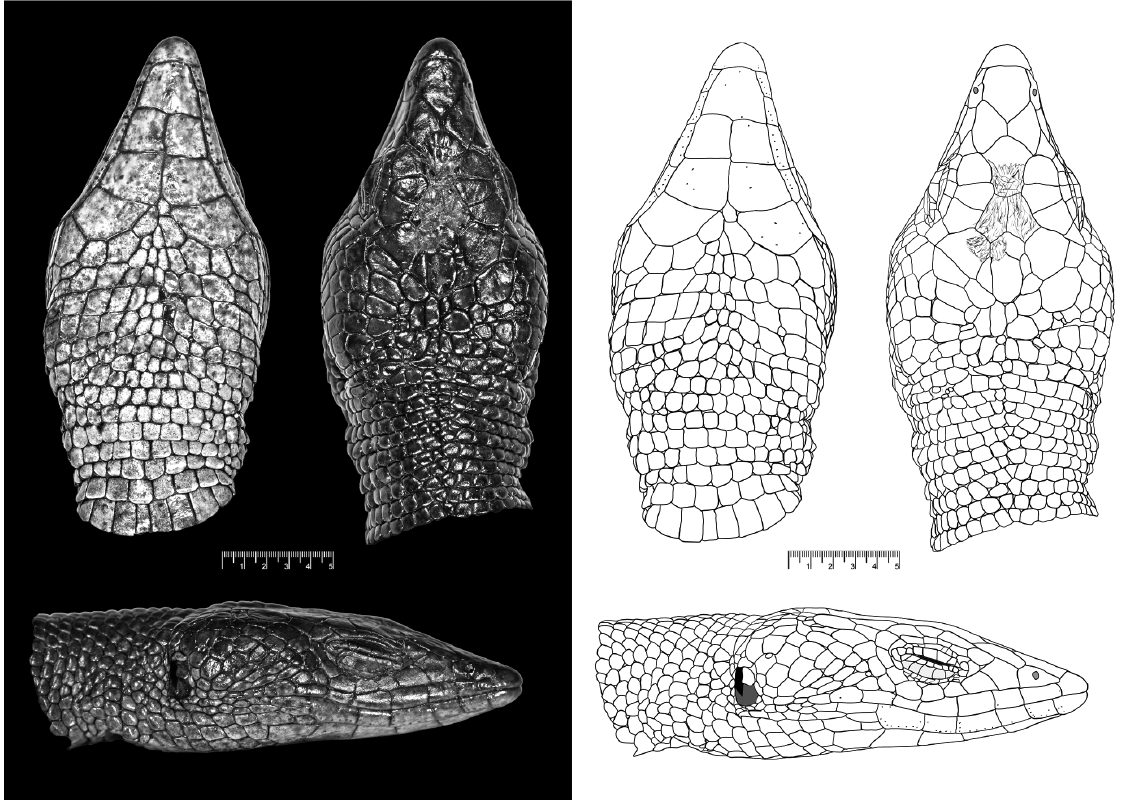
Fig. 2. Anadia mcdiarmidi sp. nov. Ventral, dorsal, and lateral views of the head of the holotype (IRSNB 2677). Scale lines = 5 mm. Photographs by Philippe J.R.